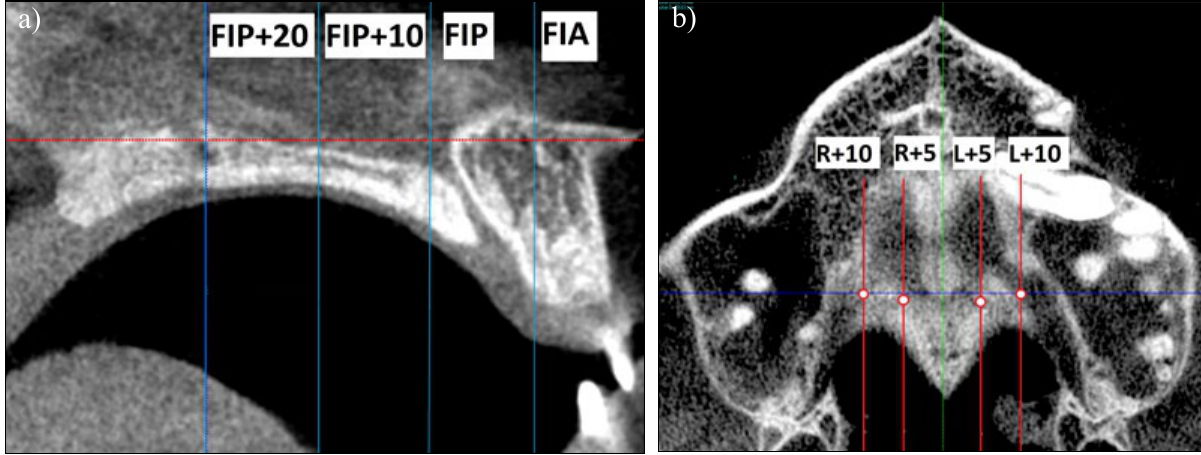
Figure 1. Panel A: Topographic points from which frontal sections were exported: FIA point – located at the anterior margin of the incisive foramen, FIP point – located at the posterior margin of the nasal exit of incisive canal, FIP+10 point – located 10 mm posteriorly from the point FIP, and FIP+20 point – located 20 mm distally from the point FIP. Panel B: Topographic points from which sagittal sections were exported: R+5 point – located 5 mm from the midline to the right, L+5 – located 5 mm from the midline to the left, R+10 located 10 mm from the midline to the right, L+10 located 10 mm from the midline to the